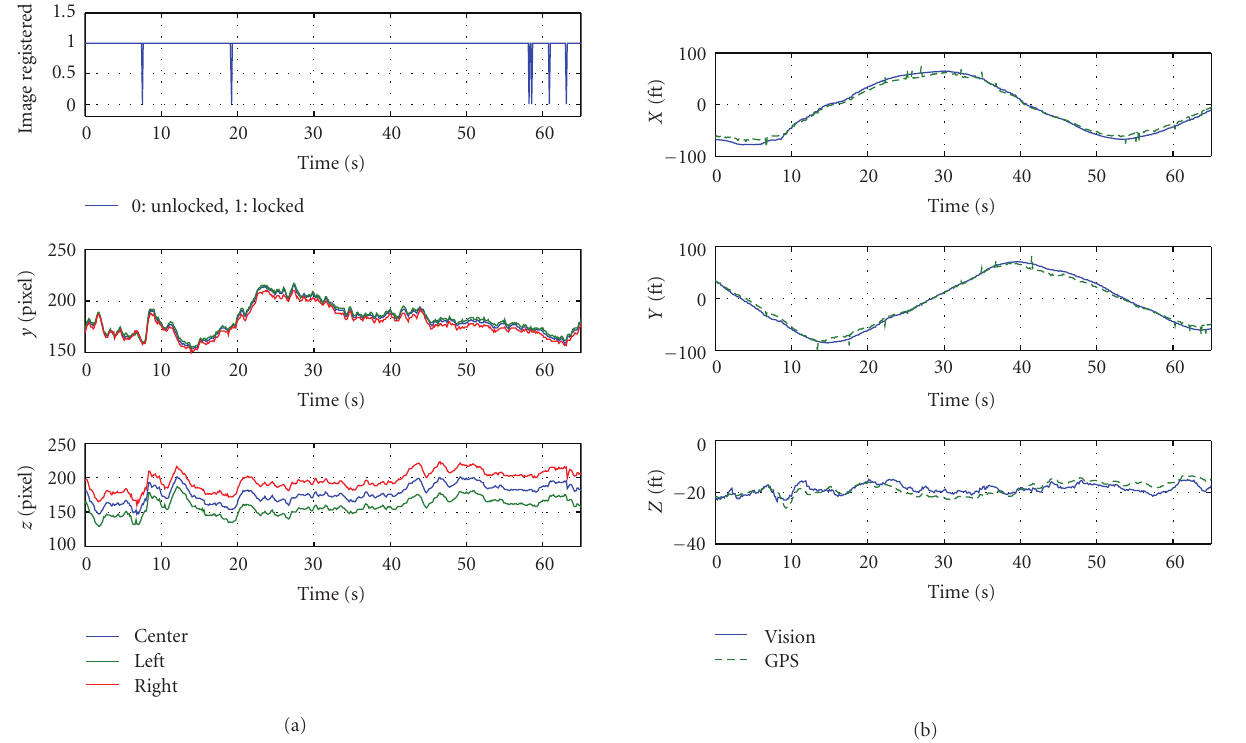
Figure 6: (GTYak-GTEdge) (a) image processor outputs, (b) vision-based versus GPS-based estimated relative position.